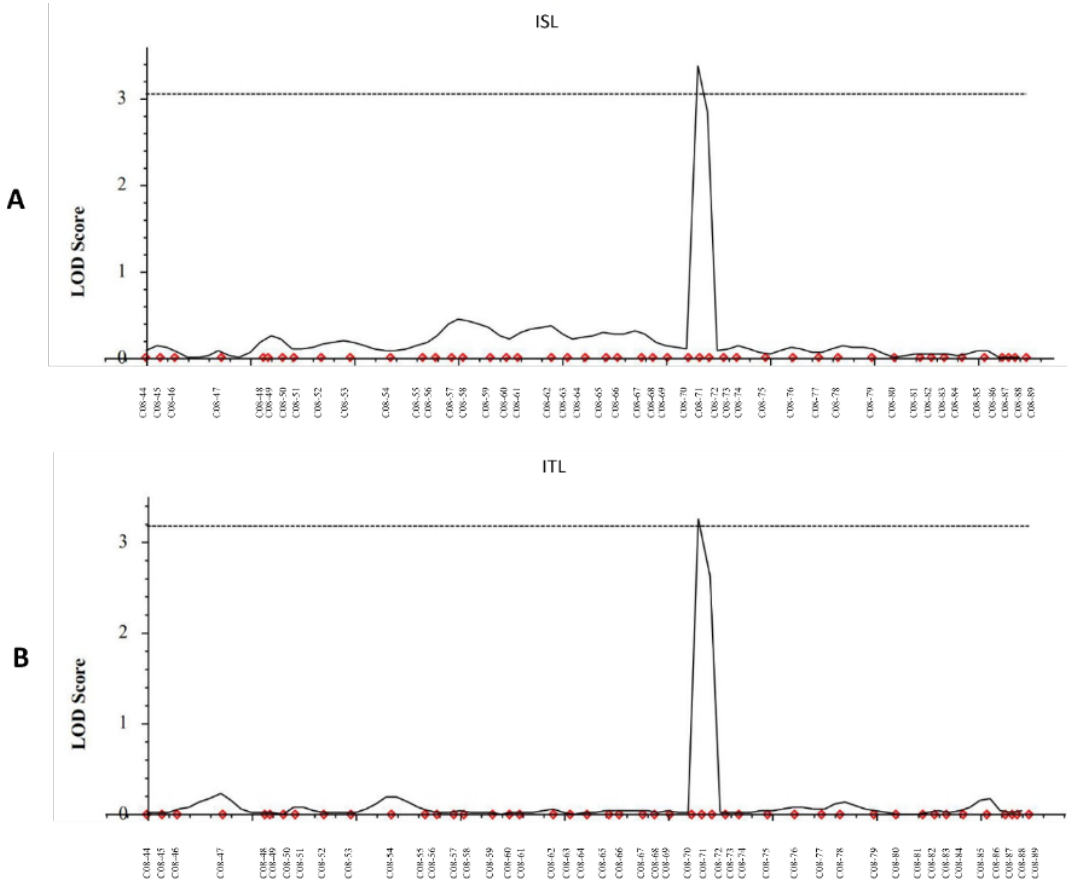
Figure 4. Detected QTLs (qISL and qITL) region associated with inhibition of growth on chromosome 8: ( A ) the LOD score of DNA markers associate with ISL (inhibition rate of shoot length) and position of qISL-8 on chromosome 8; ( B ) the LOD score of DNA markers associate with ITL (inhibition rate of total length) and position of qITL-8 on chromosome 8. Abbreviations are as follows: ISL—inhibition rate of shoot length; ITL—inhibition rate of total length. Table 1. Quantitative trait loci (QTLs) of allelopathy analyzed by inclusive composite interval mapping.